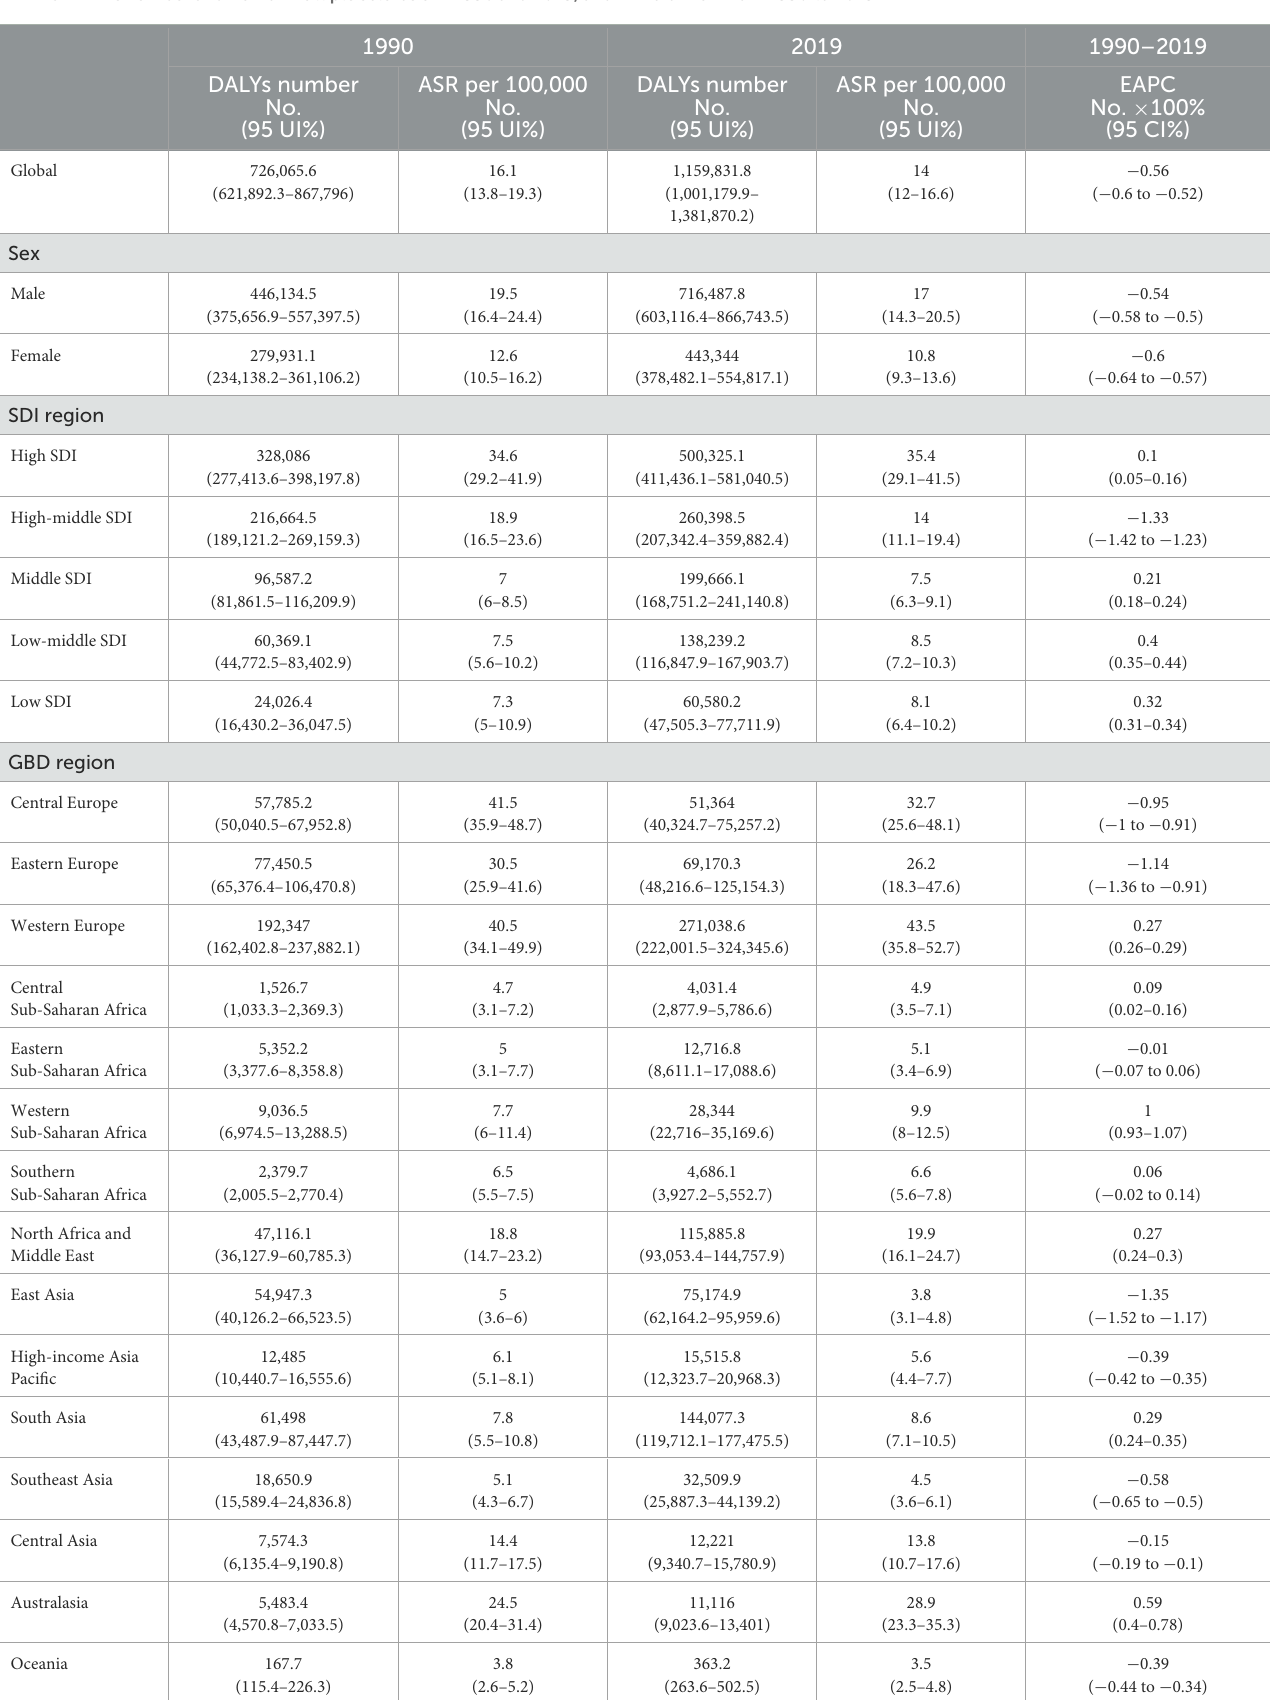
TABLE 3 DALYs number and ASR of multiple sclerosis in 1990 and 2019, and EAPC of ASR from 1990 to